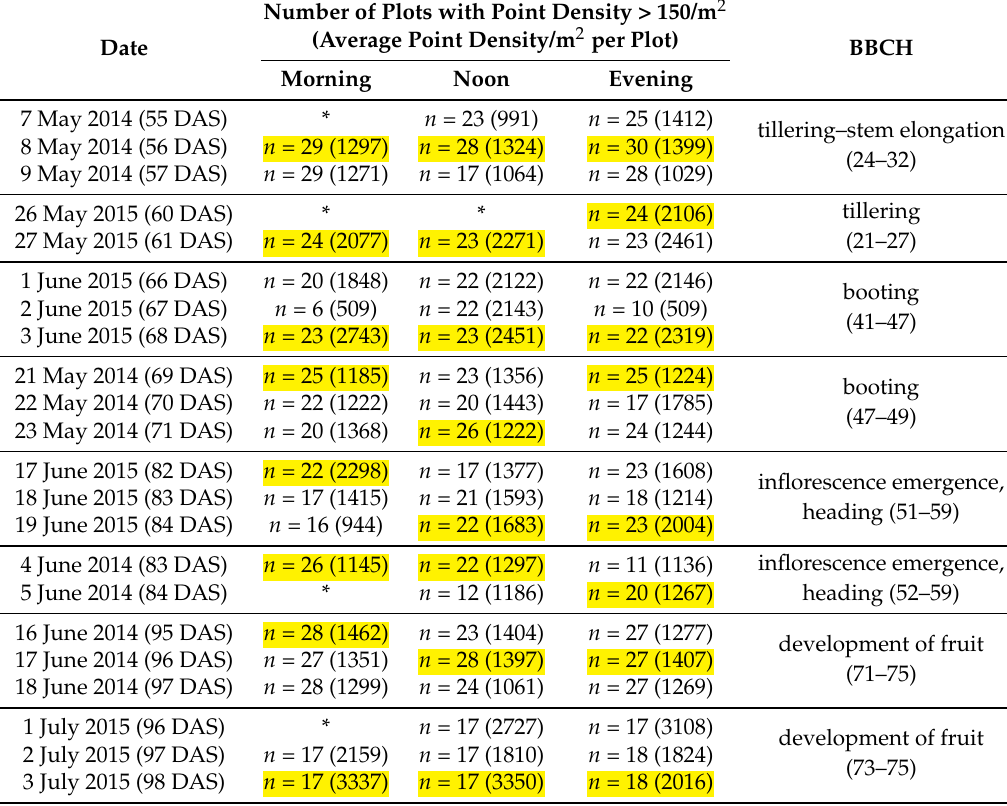
Figure 2. ( a ) Scatter plot of CSM-derived plant height vs. manually measured plant height for the selected CSMs of the noon acquisition date, p -value < 0.0001; and ( b ) overview of covered plots and point density per m 2 for 8 May 2014, noon acquisition date. Table 1. Overview of generated CSMs and corresponding BBCH values; selected CSMs highlighted. Number of Plots with Point Density > 150/m